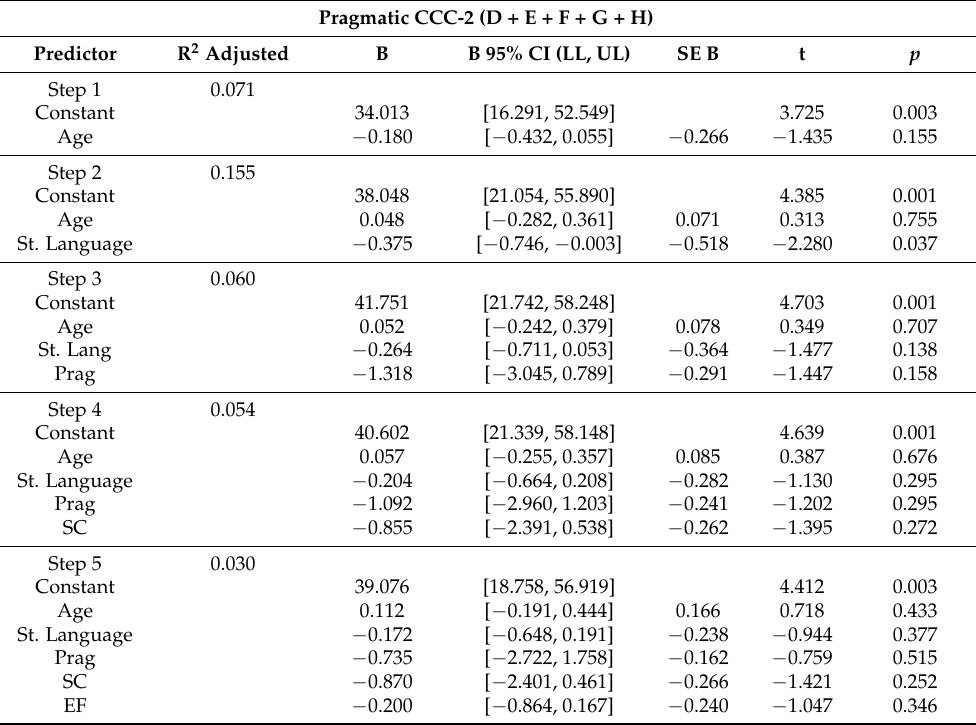
Table 6. Summary of regression coefficients for Pragmatic CCC-2 scores (D + E + F + G + H) within the DLD group bootstrap results based on 2000 bootstrap